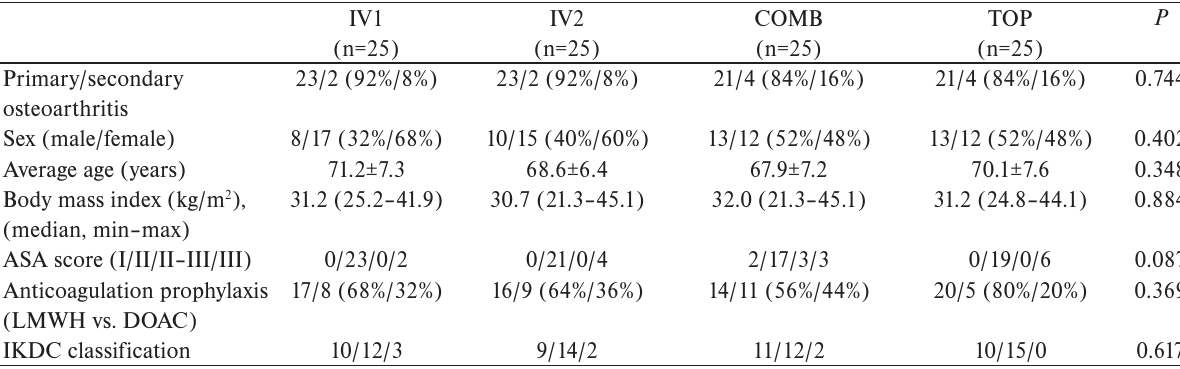
Table 1. Comparison of TXA groups in patient demographic and clinical